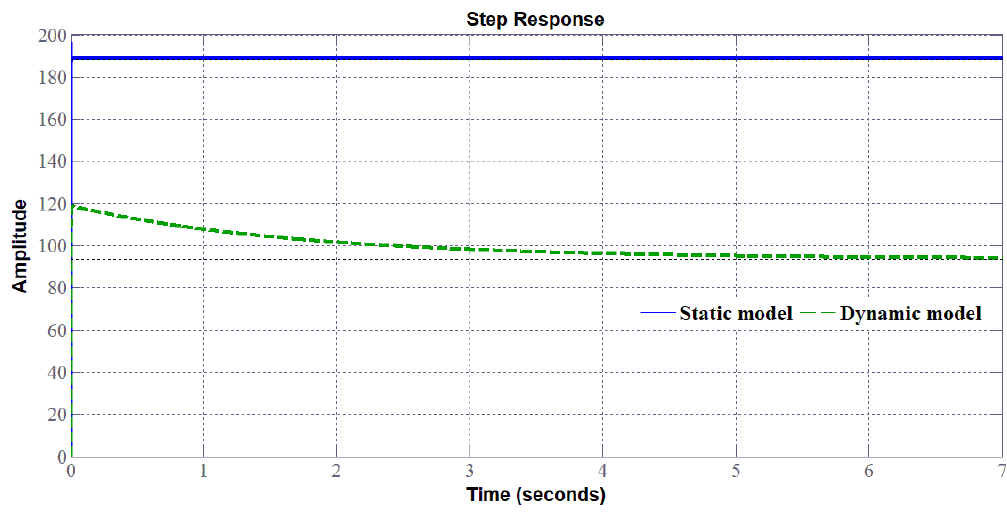
Figure 24. Slow response of the system with the dynamic model.